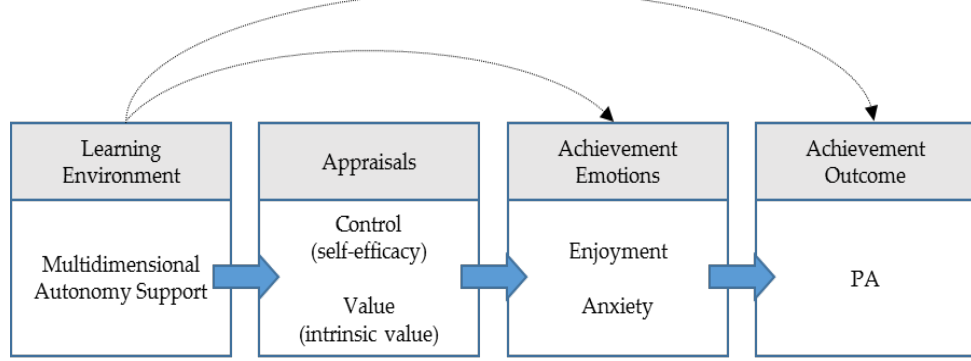
Figure 1. Hypothesized model of the present study based on the control-value theory (CVT) (Pekrun, 2006).